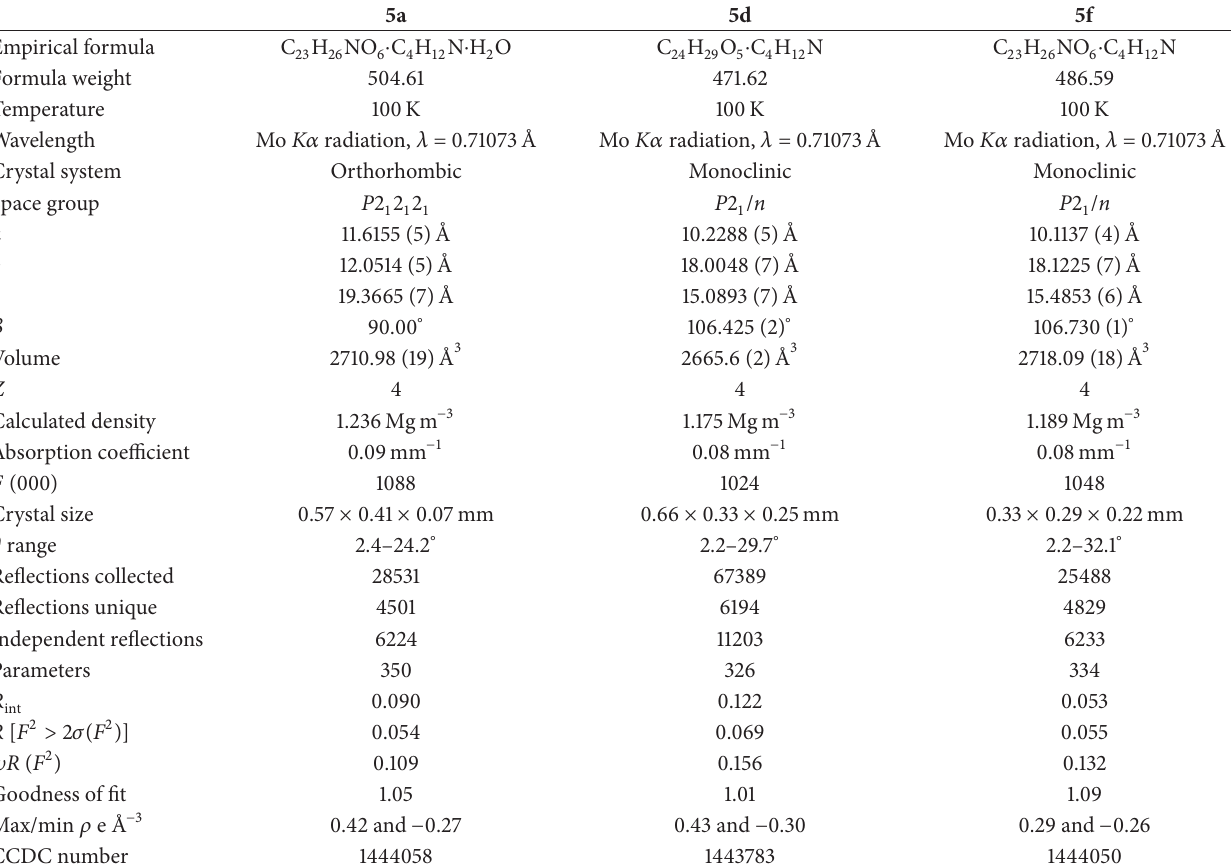
Table 1: The crystal and experimental data of compounds 5a , 5d, and 5f